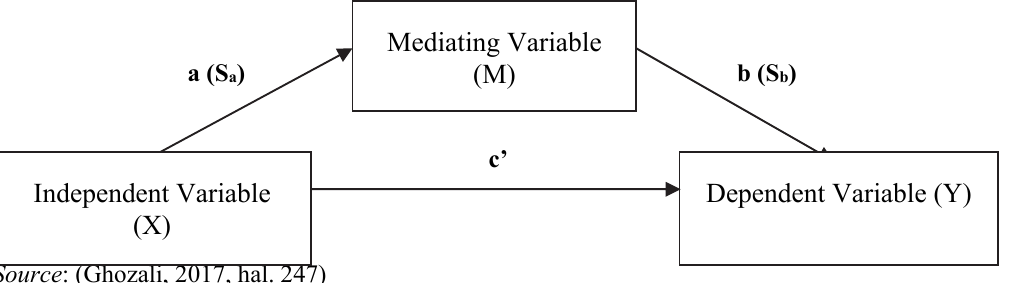
Fig. 3 . The relationship betwixt Independent and Dependent Variables with the Effect of Mediator (Intervening)